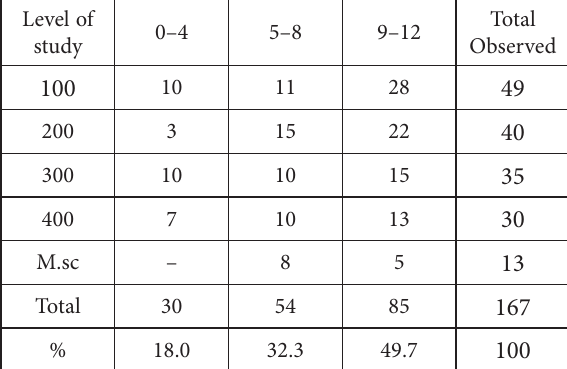
Table 3. Distribution of scores of statistical mapping test